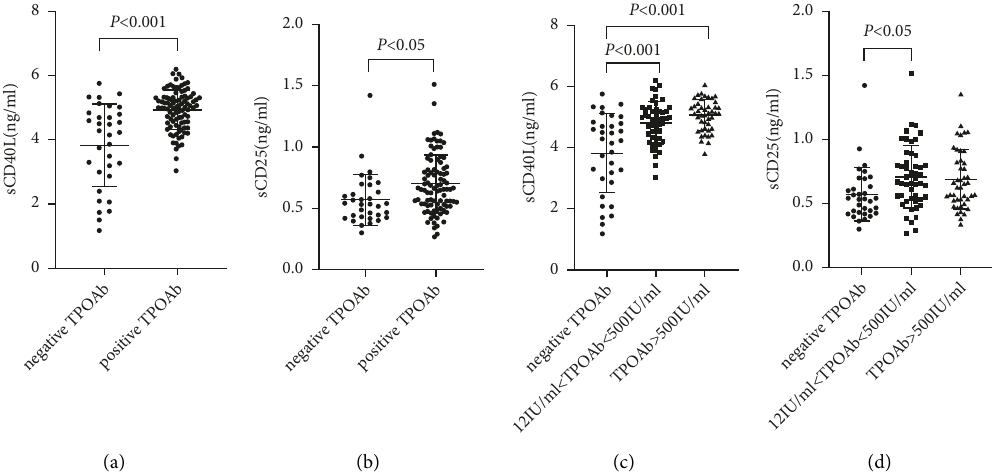
Figure 2: The comparison of sCD40L and sCD25 according to TPOAb positivity and TPOAb titers (a) showed the comparison of sCD40L in the negative TPOAb group and the positive TPOAb group; (b) showed the comparison of sCD25 in the negative TPOAb group and the positive TPOAb group; (c) showed the comparison of sCD40L according to TPOAb titers; (d) showed the comparison of sCD25 according to TPOAb titers. Comparisons of sCD40L and sCD25 levels between the three groups were performed by ANOVA test and Bonferroni correction was used for post hoc